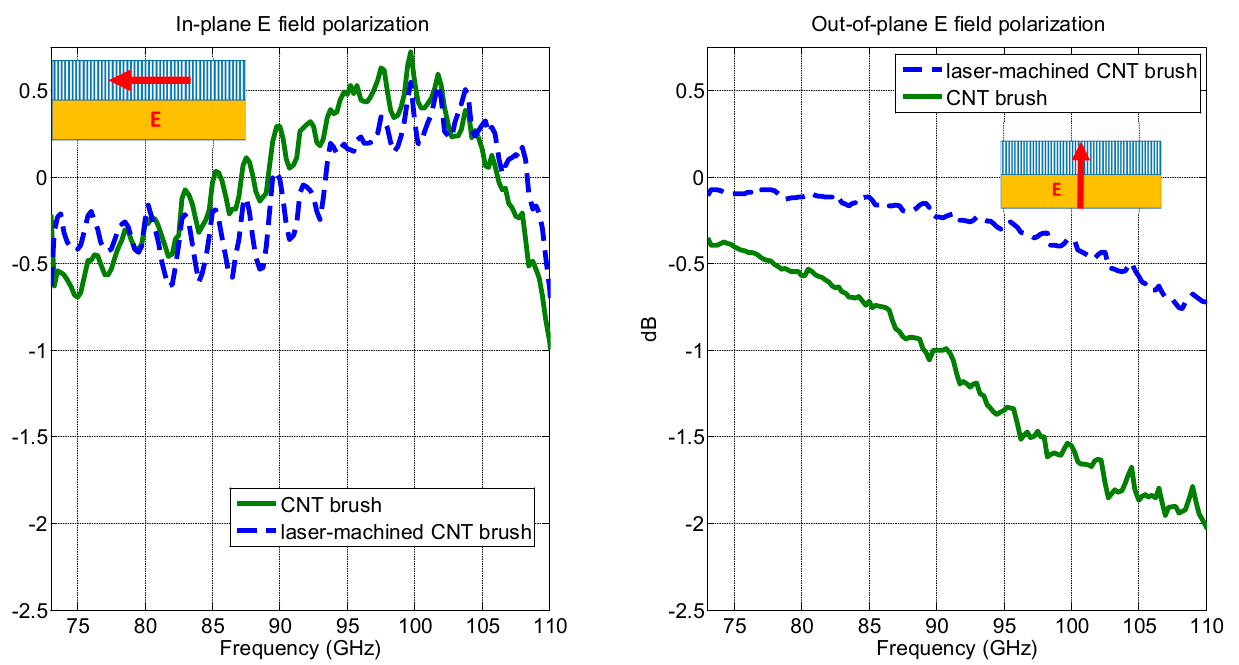
Figure 6. Measurement of transmission for incident E field polarization shown in the inset, without (solid) or with (dashed) laser-patterning of the CNT brush (100 µm square micro-pillars spaced by 50 µm, 5 mm square). Measurements are normalized to the transmission measured for a quartz sample without CNT